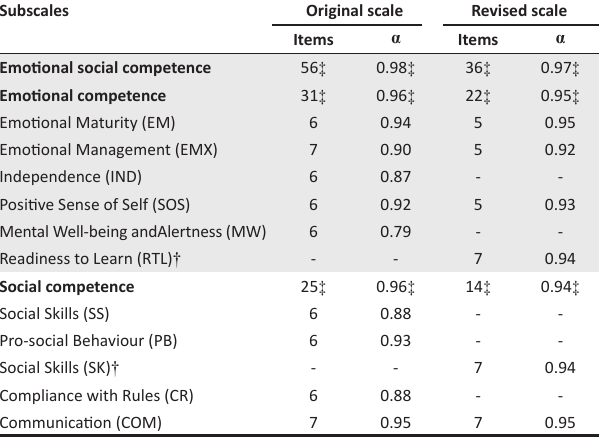
TABLE 4: Internal consistency for the original and revised scales and subscales of the emotional social screening tool for school readiness before and after principal axis